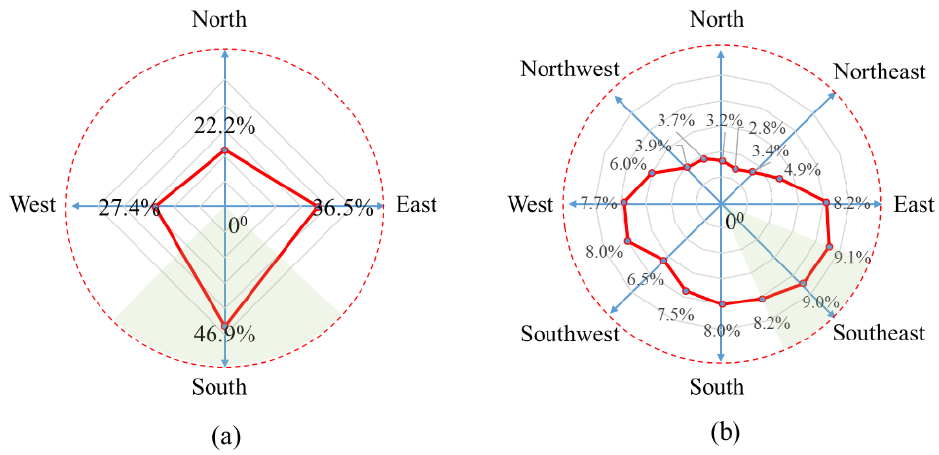
Figure 12. Comparison with field investigation in the location of roof damage. ( a ) the result of the location of the roof damage in the field investigation. ( b ) the result of the location of the roof damage using deep learning.